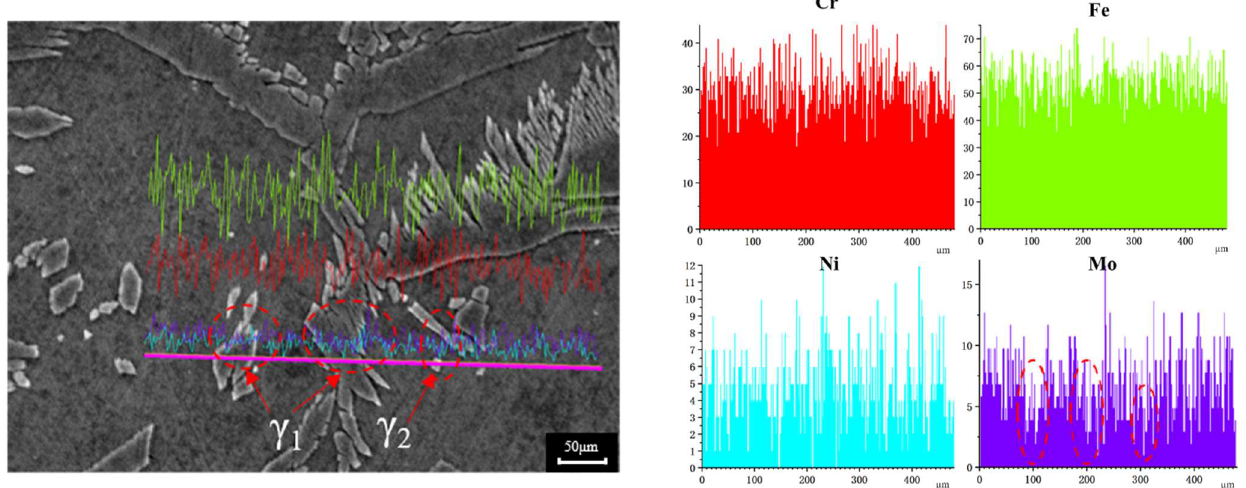
Figure 4. Line mapping analysis on the weld structure (color lines represent different elements).